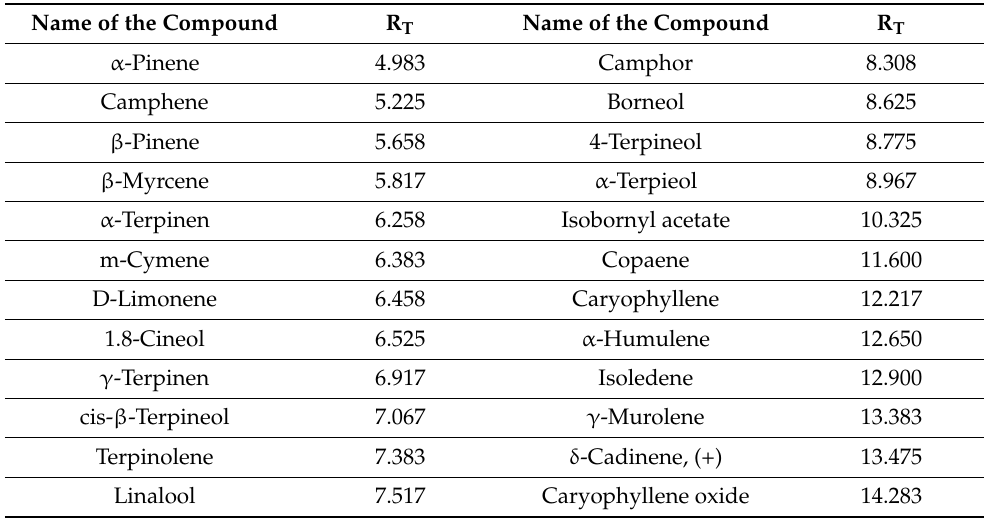
Table 2. Chemical profile of Rosmarinus officinalis L. essential oil (R T is the retention